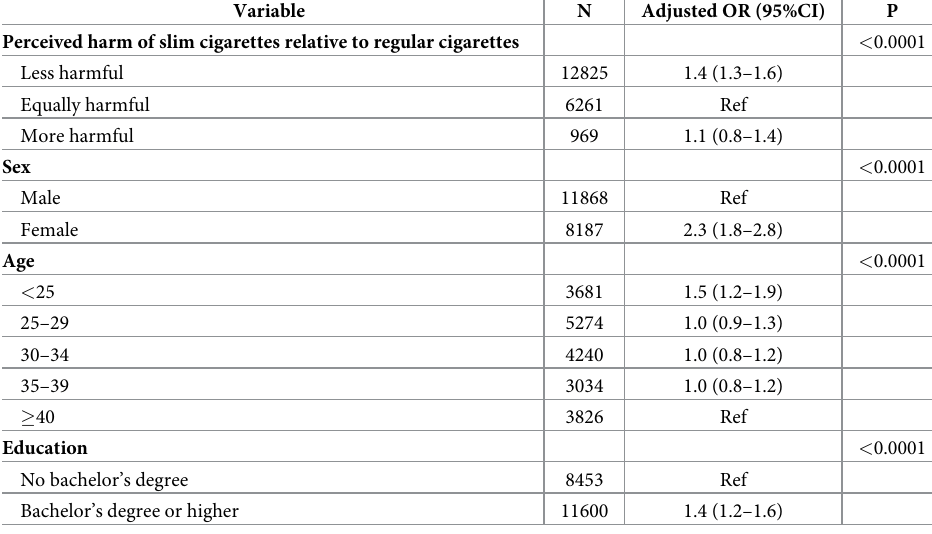
Table 5. Factors associated with slim cigarette use among current